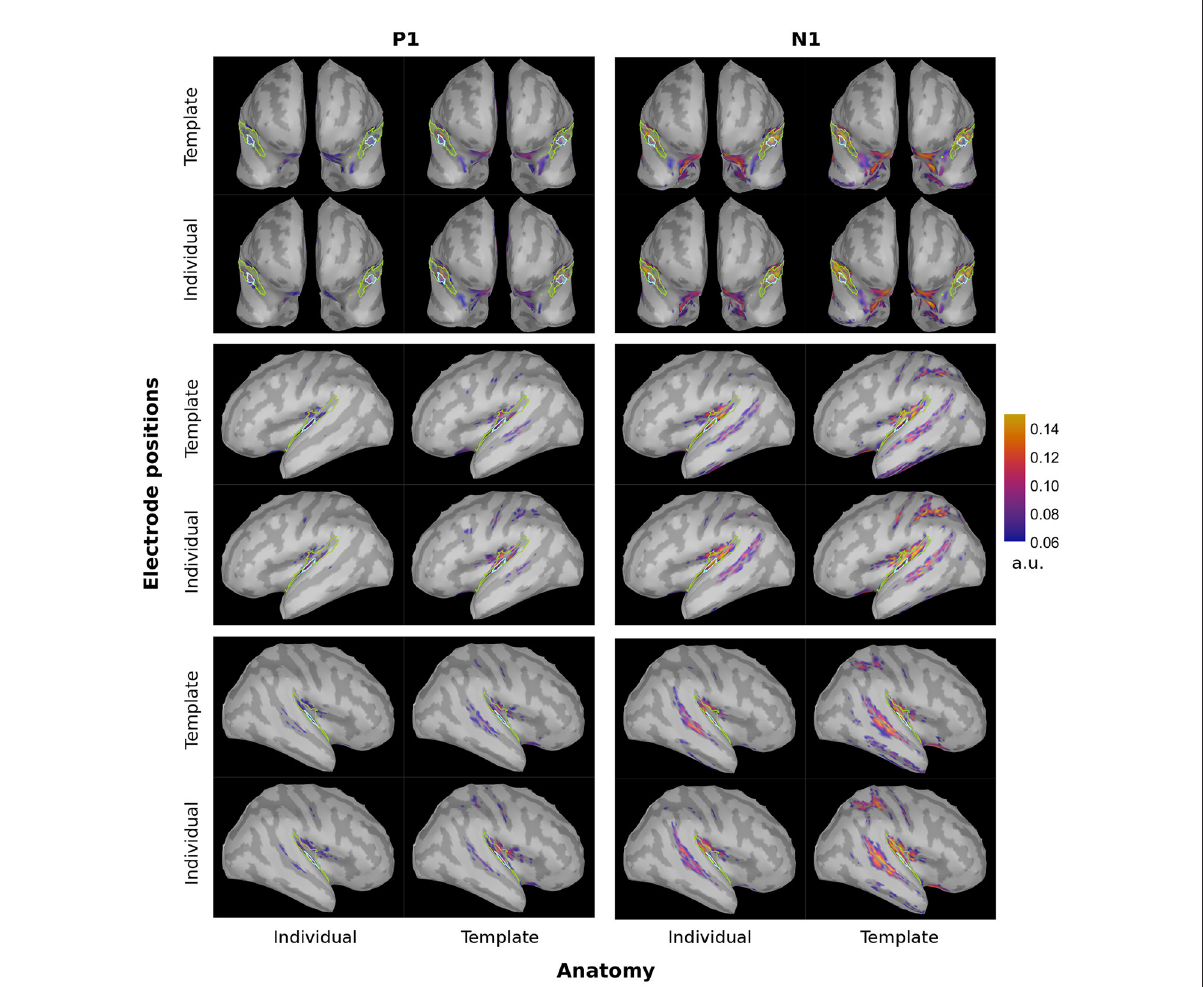
FIGURE4 dSPM brainmaps depicting the PAC activation at the P1 ( ∼ 55 ms, top) and N1 ( ∼ 100 ms, bottom) timing for both hemispheres and all considered configurations. For display, no minimal cluster size was set and the minimum amplitude was set at 20% of the maximum activation across all four configurations of the inverse solution. Cyan: atlas-defined PAC; Green: extended